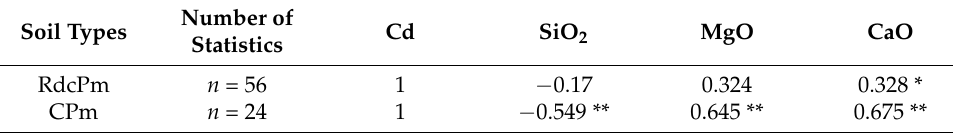
Table 3. Correlation analysis between Cd element and oxide in soil.